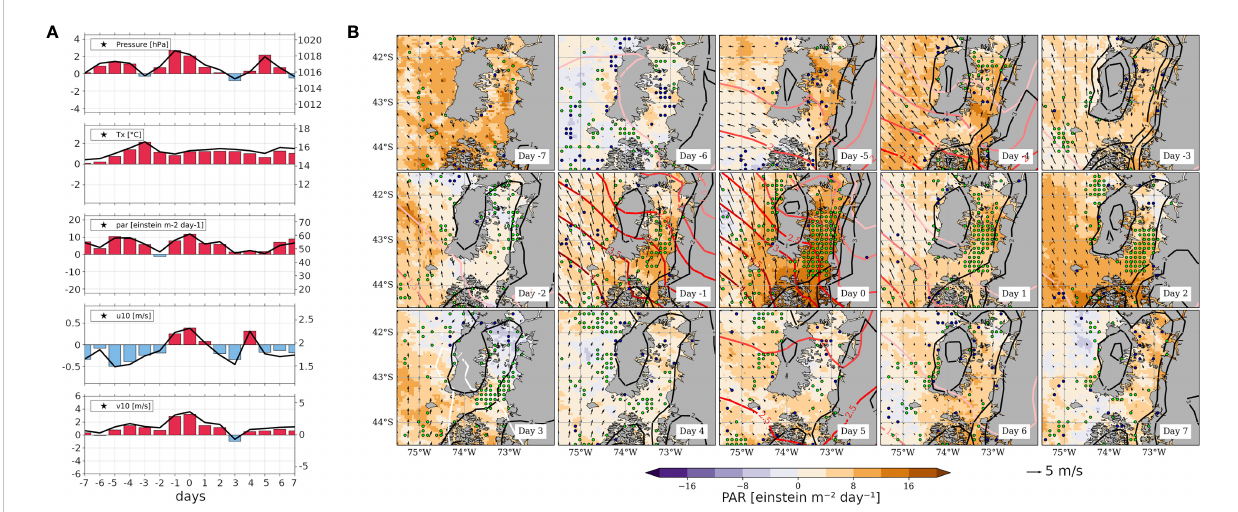
FIGURE 4 (A) Composite time series averaged from the 16 HBE within the S-ISC subregion (42.5°-43.5° S; see Figure 1A) for a sequence centred on the HBE onset, i.e., on day 0, spanning from day -7 to day +7. Variables correspond to MSLP [hPa], Tx [°C], PAR [einstein m -2 day -1 ], and U and V components of wind at 10m [m s -1 ]. The right-hand y-axis of each panel shows the absolute values on solid black lines centred around the mean DJF value (central horizontal line), while the left y-axis shows the positive (negative) SY-IS anomalies on red (blue) bars centred around 0. (B) As Figure 2A, but showing PAR ’ (shaded, see colour scale), MSLP ’ (reddish contours every 0.5 hPa), Tx ’ (black contours every 1°C), 10m wind (black vectors, reference vector below the fi gure), and nFLH ’ (green [blue] dots depict gridpoints with nFLH ’ >0.1 [nFLH ’ <-0.1] W m -2 µm -1 sr -1